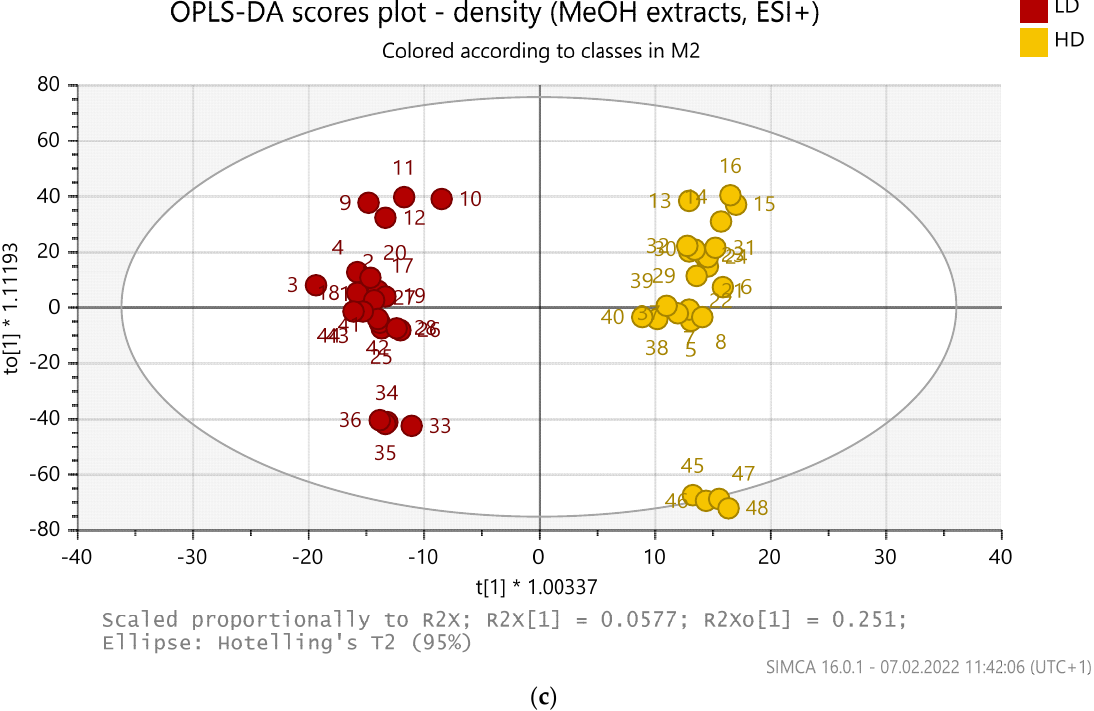
Figure 3. OPLS-DA model of 48 samples (methanolic extracts, positive ion mode). The samples are clustered according to: ( a ) farming system (conv = conventional, int = integrated, org = organic), ( b ) variety, and ( c ) planting density (LD = low density, 6 × 10 5 seeds per ha, HD = high density, 9 × 10 5 seeds per ha).